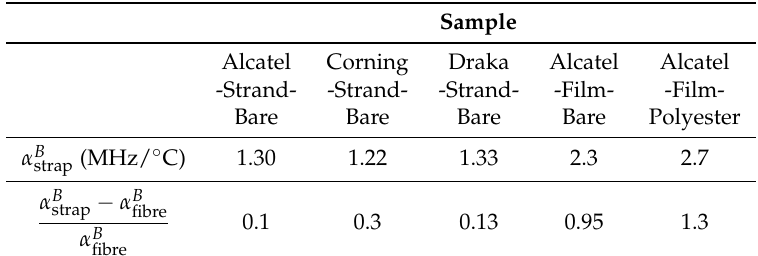
Figure 9. Variation of Brillouin frequency shift with temperature. Table 1. Coefficients of variation of Brillouin frequency shift with